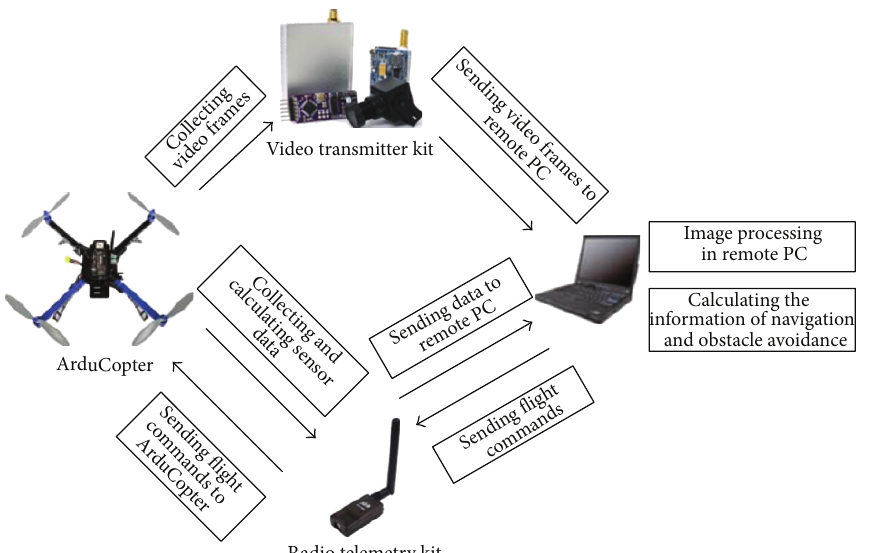
Figure 8: Workflow of the whole quadrotor helicopter